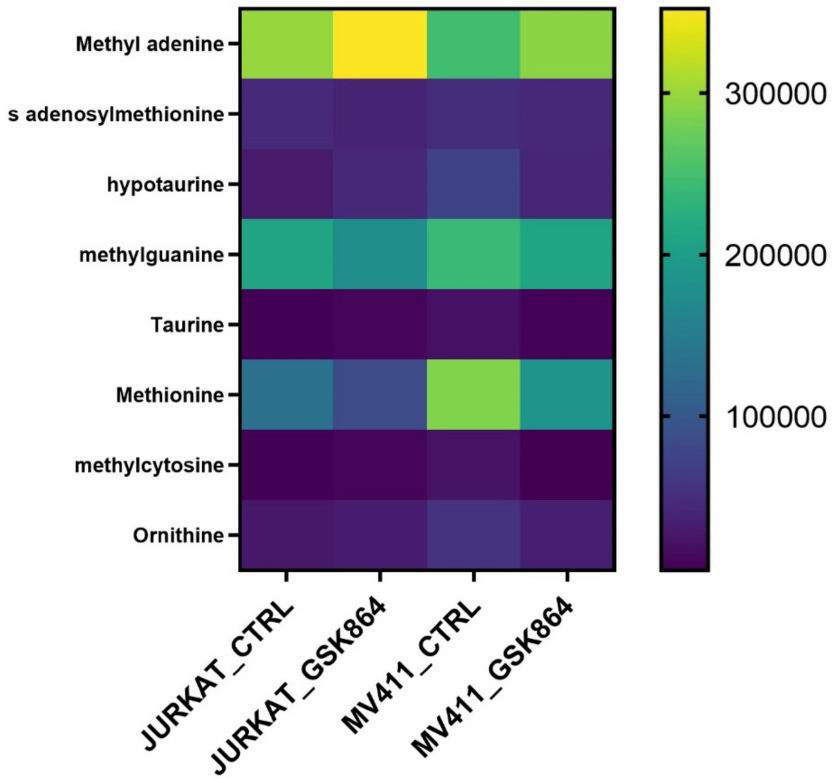
Figure 5. IDHi alters one-carbon metabolism in leukemic cells. Quantitative levels of various metabolites involved in control and GSK864-treated cells involved in one-carbon